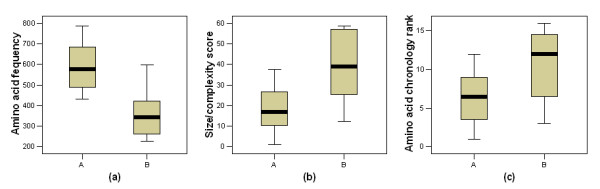
Frequency (a), Size/complexity score (b) and Chronology rank (c) of amino acids in Group A versus Group B. The bars designate the minimum and maximum values, the box designates the interquartile range, and the thick line in the middle represents the median.